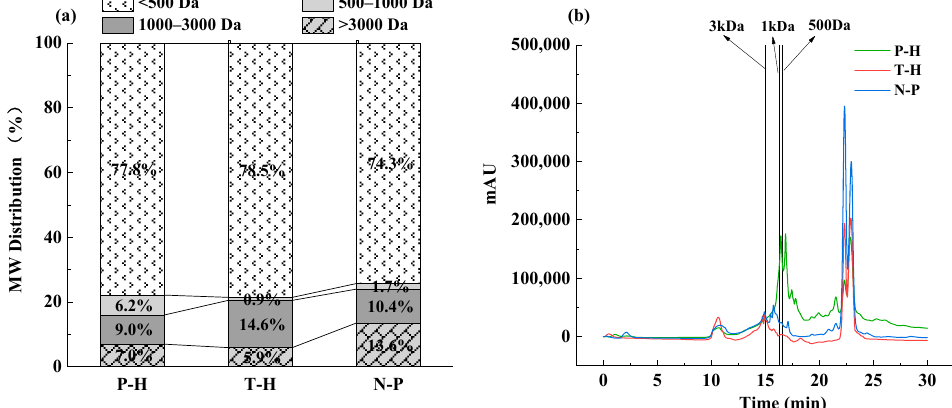
Figure 1. ( a ) Molecular weight distribution and ( b ) liquid chromatogram of three P. crocea peptides.